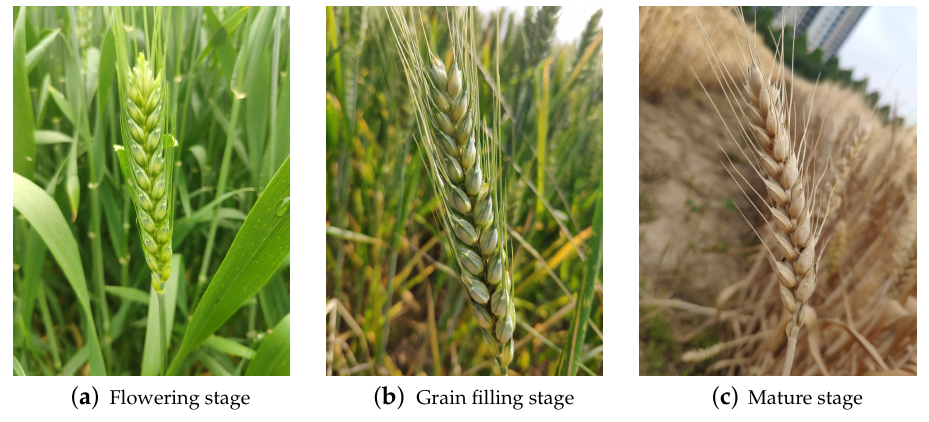
Figure 1. Different stage samples of the captured images.